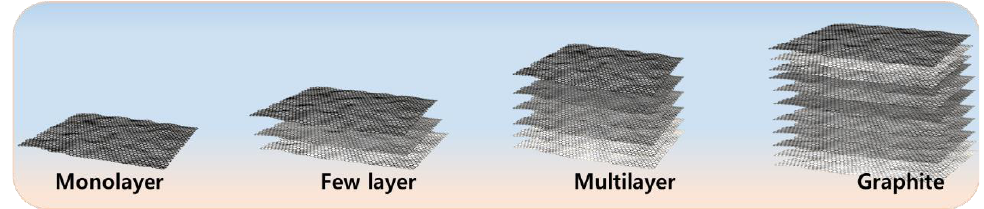
Figure 1. Schematic overview of monolayer, few-layer and multi-layer